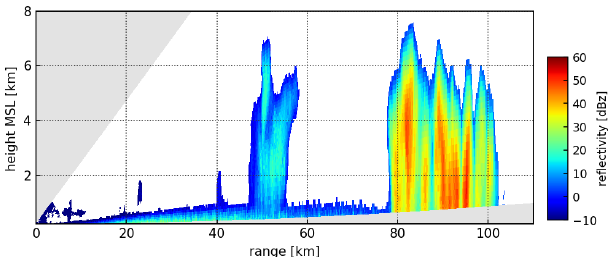
Figure 10. RHI scan on 9 February 2020 at 16:19UTC towards 71 ◦ . Note that the shallow layer with low reflectivity is sea clutter.